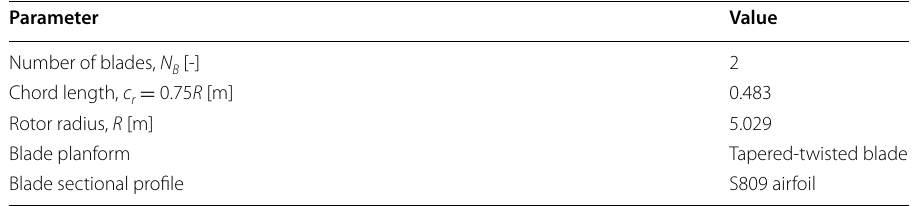
Table 6 Flow conditions for NREL Phase VI rotor simulation Parameter Value Collective pitch angle, θ c [deg.] 4.815 Tip pitch angle, θ tip [deg.] Rotating speed, Ω [rpm] 72 Tip Mach number, M tip [-] 0.11 Wind speed, V [m/s] 5, 7, 10, 15, 20, 25 ∞ Yaw angle, β